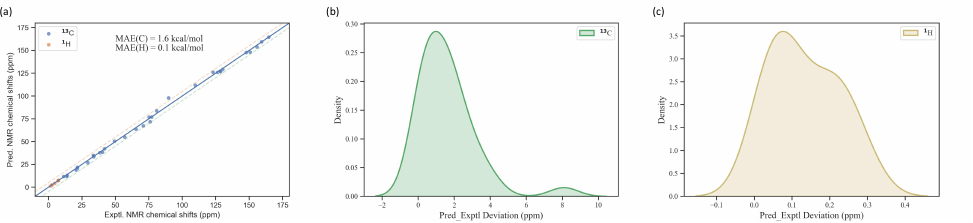
Figure 5. ( a ) Comparison between the predicted and experimental NMR chemical shifts for 459 13 C and 213 1 H chemical shifts contained in our original data set. ( b ) Distributions of errors between the predicted and experimental 13 C NMR chemical shifts. ( c ) Distributions of errors between the predicted and experimental 1 H NMR chemical shifts.